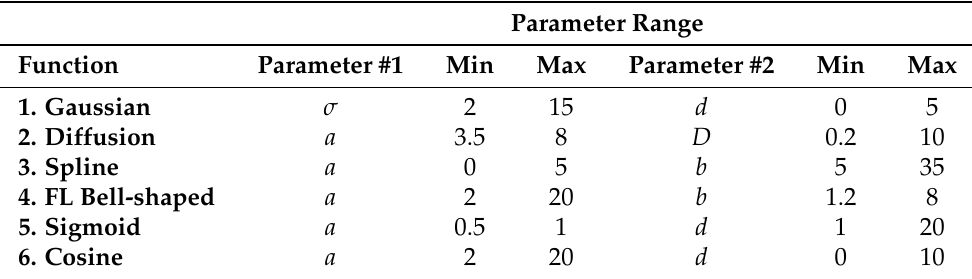
Table 1. Summary of the parameter ranges of the functions used to generate 1D edge templates of protein spots. The generation of 1D template samples is done by randomly selecting a function and its parameters from the provided